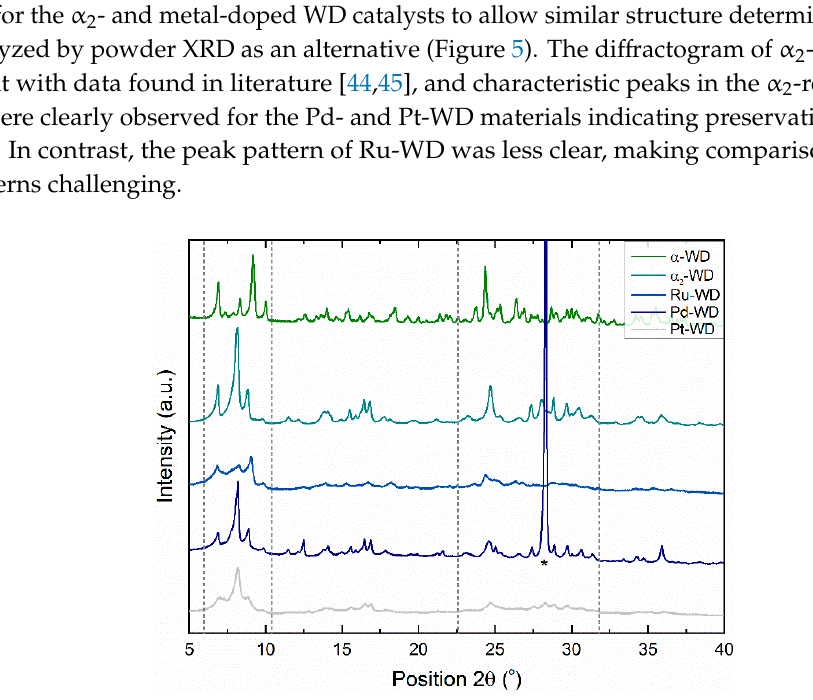
Figure 5. Powder XRD of the prepared WD materials (* indicates KCl impurity).